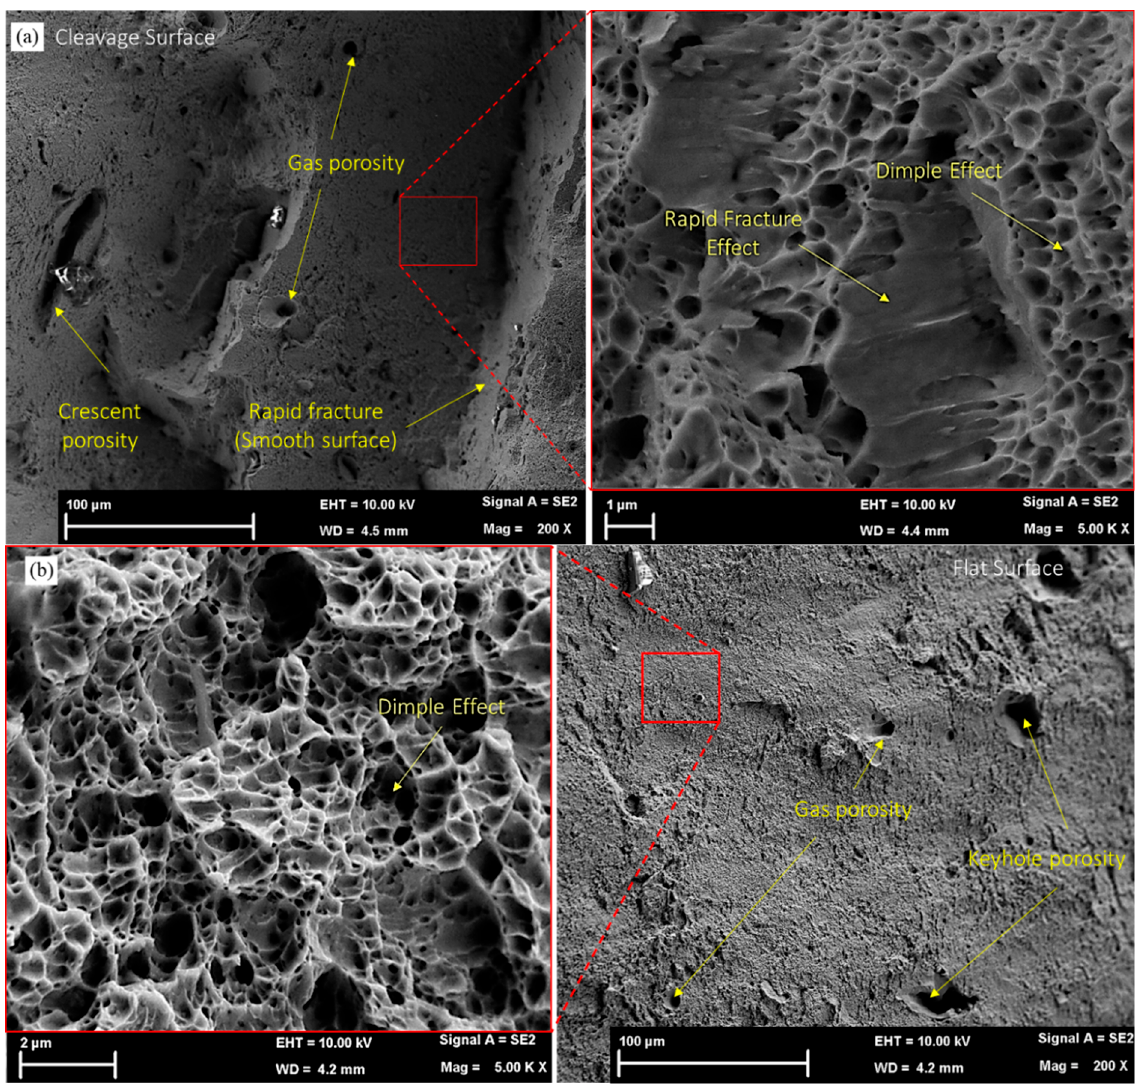
Figure 21. SEM of a fractured surface under 200× and 5000× magnification for ( a ) cleavage surface and ( b ) flat surface.